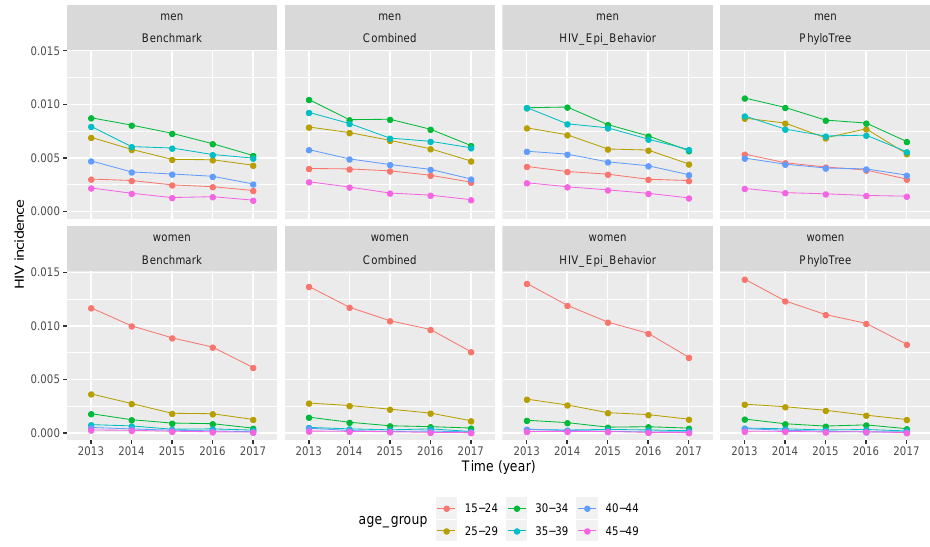
Figure 4. Temporal trends of HIV incidence produced by vectors of retained parameter values. Incidence values from benchmark data and after calibration when the simulation was performed by vectors of retained parameters. (Combined features—2nd column, epidemiological and behavioural features—3rd column, and phylogenetic features—4th column).